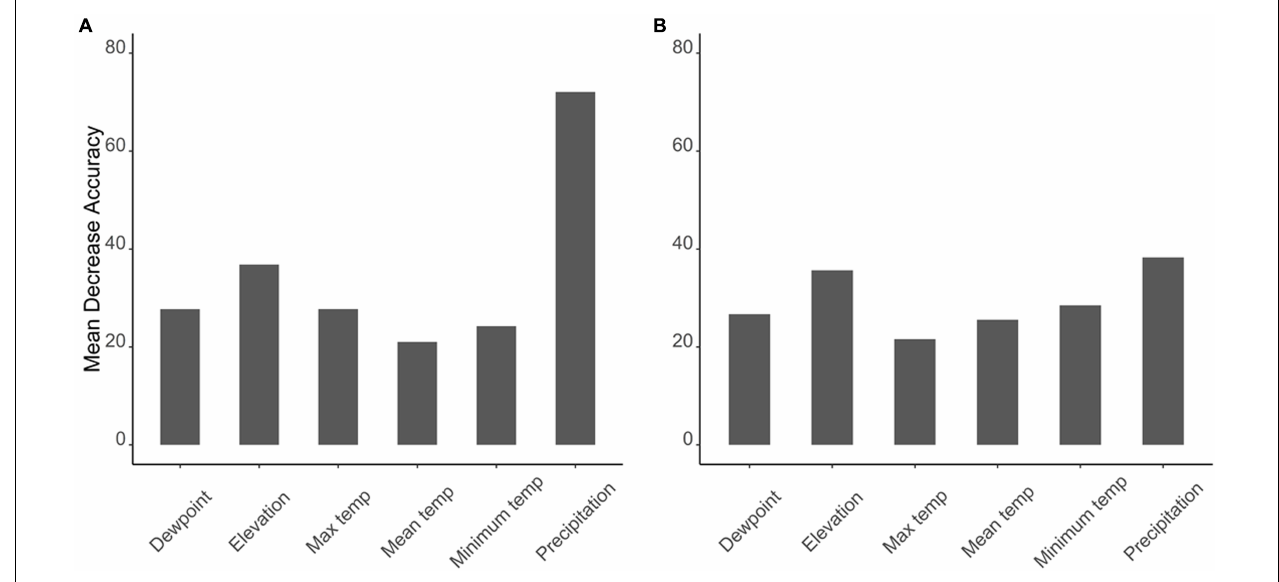
to contribute to both the temporal and geographic segregation of these